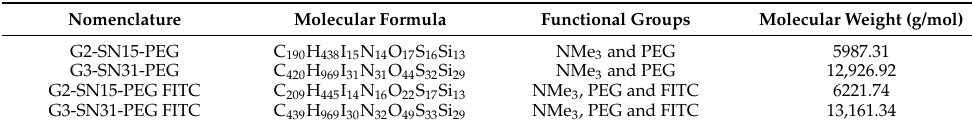
Table 1. Characterization of PEGylated cationic carbosilane